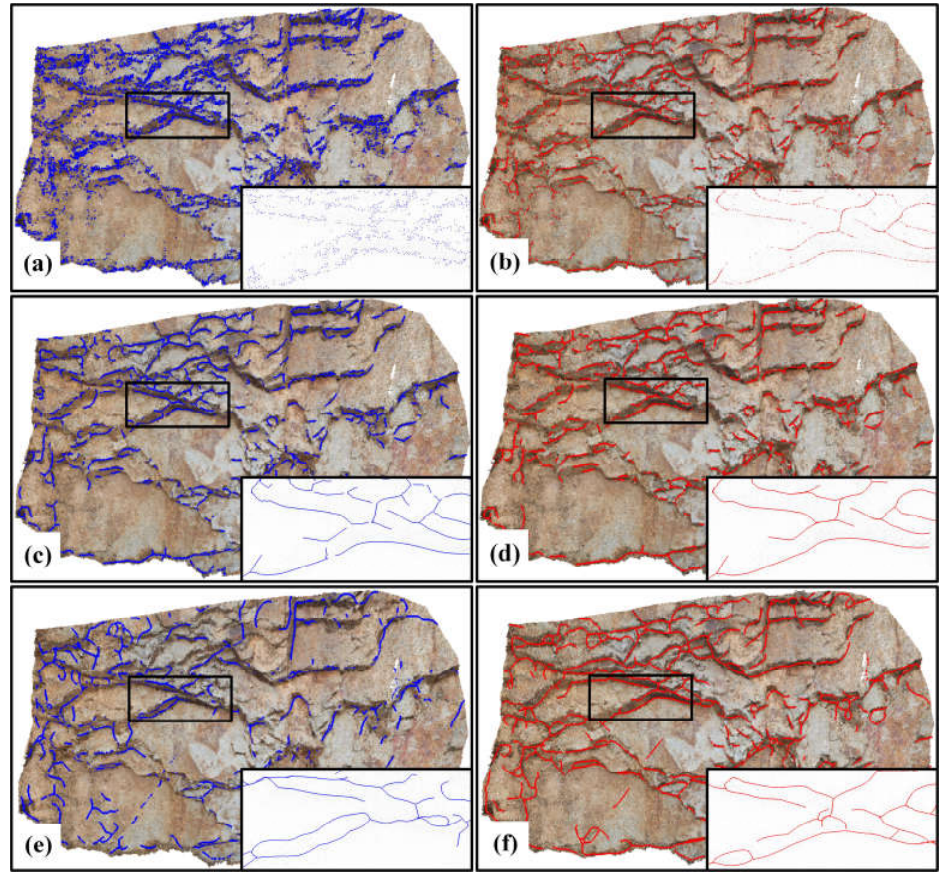
Figure 18. Case A: Overall process of analysis and comparison. ( a ) Potential discontinuity trace points extracted from the color attributes; ( b ) discontinuity trace points optimized using the local straight-line normalization smoothing algorithm; ( c ) discontinuity traces connected using the tradi- tional region-growing algorithm and the connectivity judgment algorithm; ( d ) discontinuity traces connected using the proposed connection algorithm; ( e ) discontinuity traces extracted from the geometric attributes; ( f ) the results of fusing the color and geometric attributes.